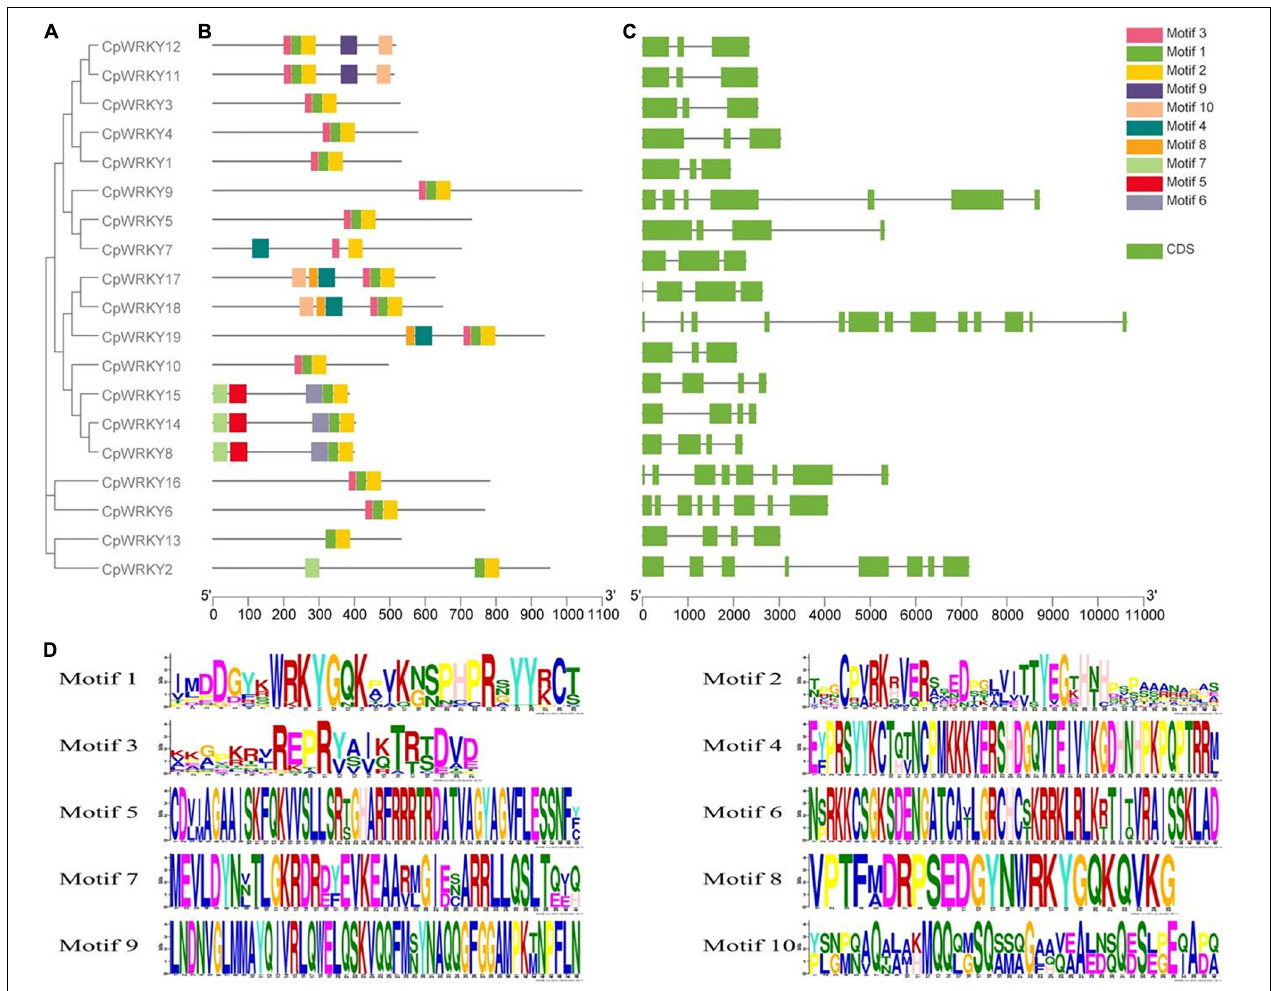
FIGURE 3 | Evolutionary tree, conserved motif distribution and gene structure of CpWRKY genes. (A) The evolutionary tree of CpWRKY. (B) The conserved motif of the members of CpWRKY family. (C) Gene structure of CpWRKY family members. (D) Conserved motif sequences (the numbers represent the length of the